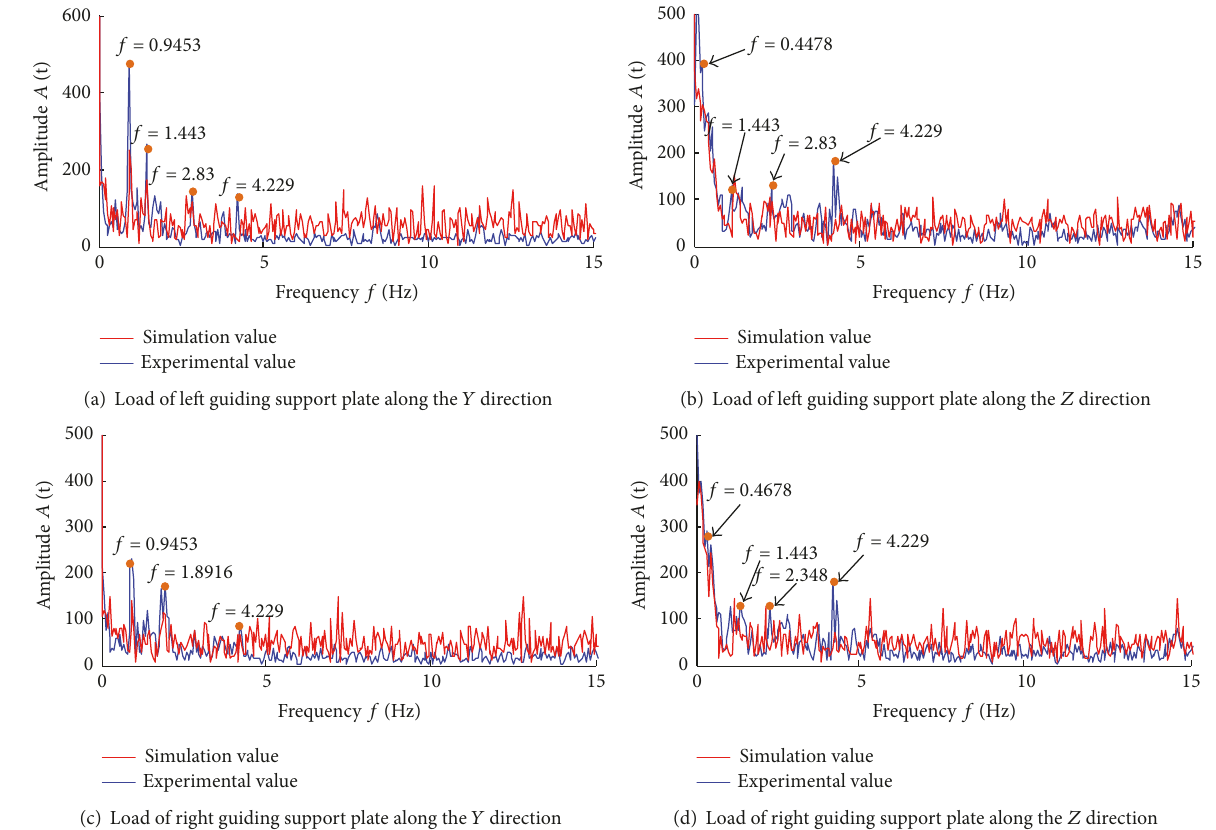
Figure 10: Amplitude-frequency response curves for guiding support